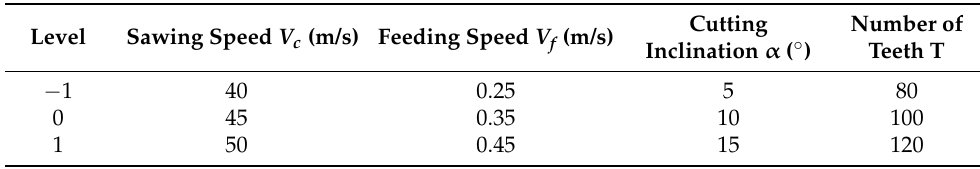
Table 2. Factors and levels of the multi-factor test.